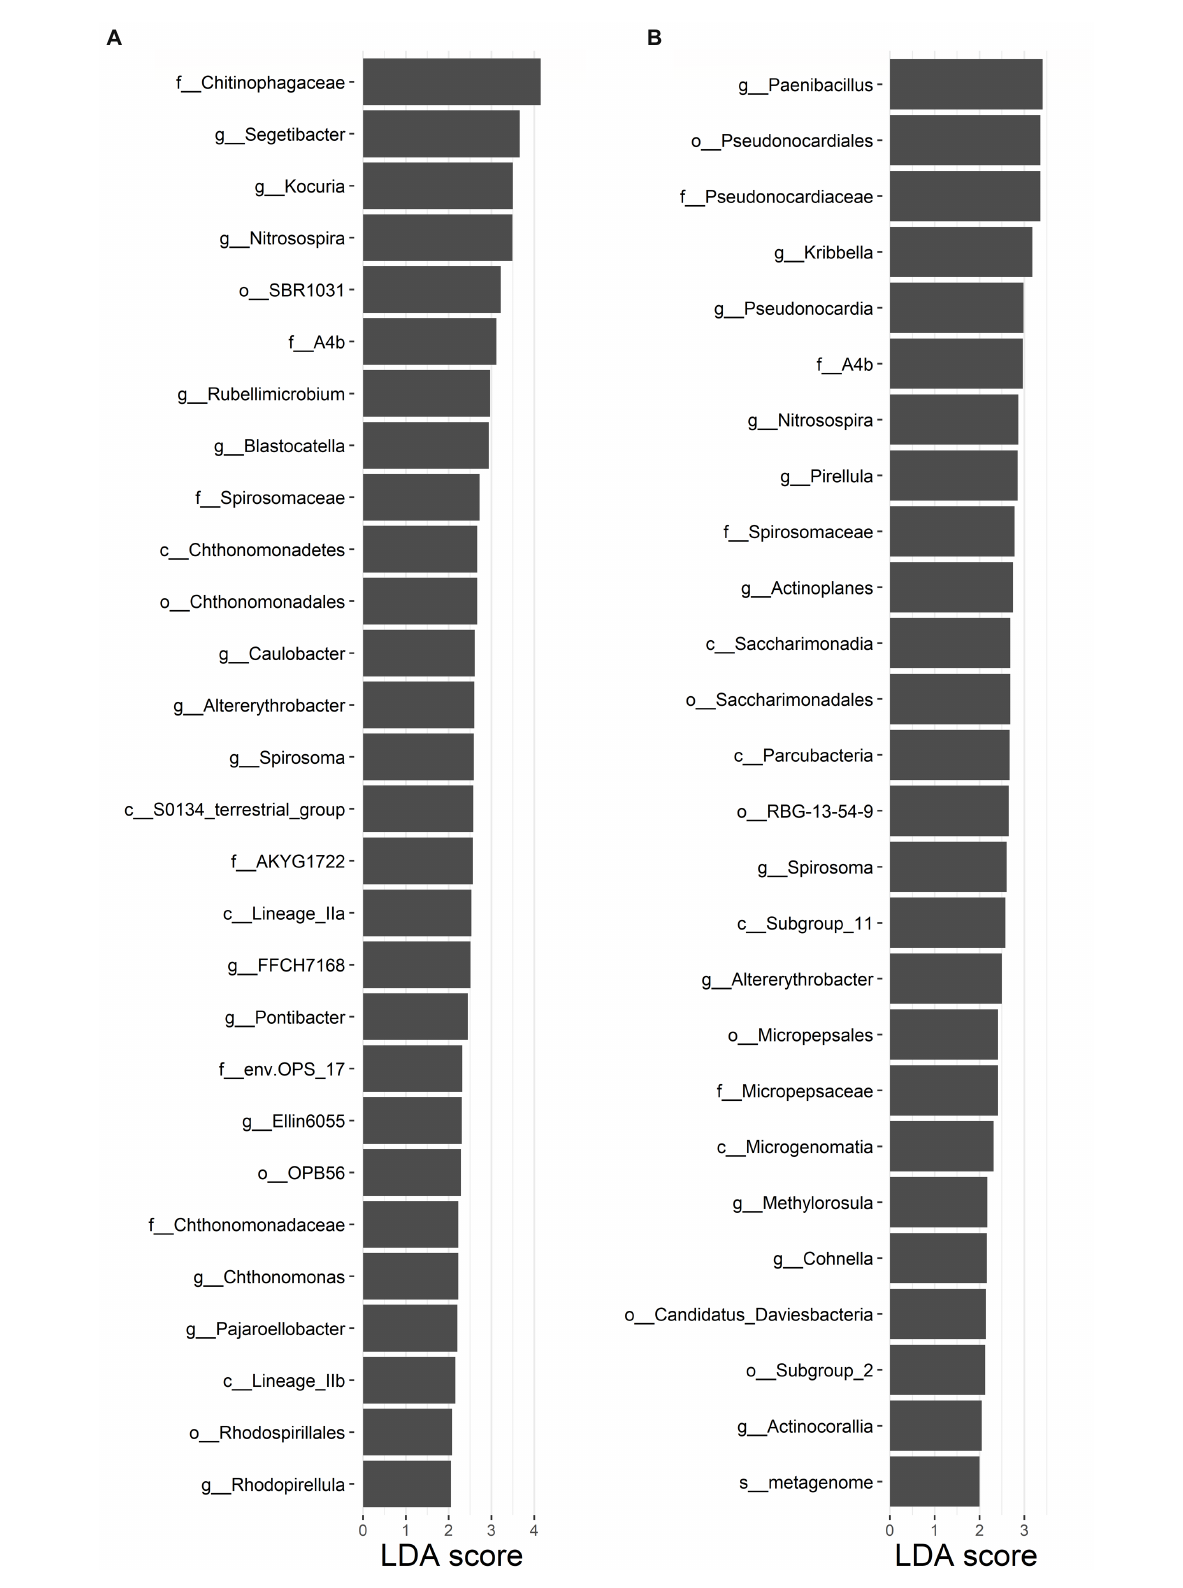
FIGURE 3 Soil bacterial community with linear discriminant analysis (LDA) scores >2 in (A) surface soil and (B) subsurface soil in an alpine